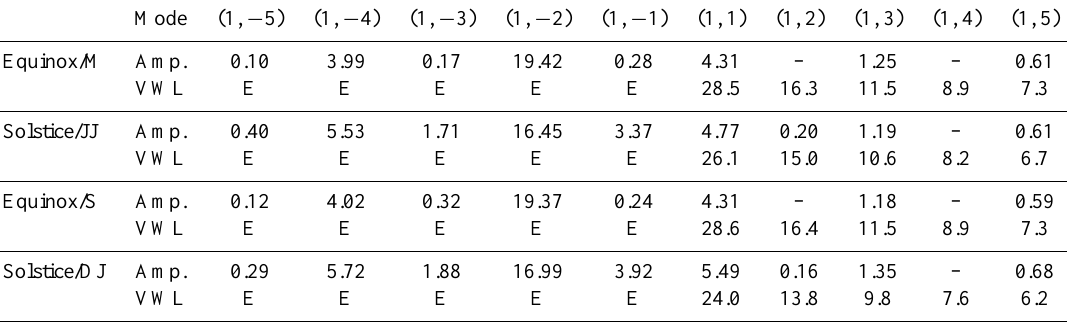
Table 1a. The amplitudes (Amp.) (Kday − 1 ) and the global averaged vertical wavelength (VWL) (km) of the diurnal heating Hough modes near the peak ( ∼ 45km) at 4 seasons.